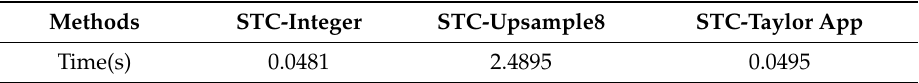
Table 1. Time consumption of processing one image using different STC-based methods.